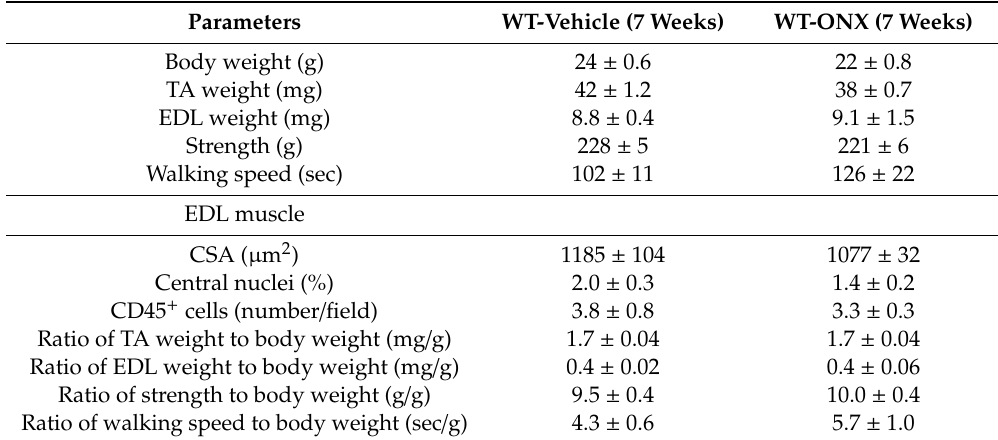
Table 2. ONX-0914 treatment for a period of 9 days in WT mice.